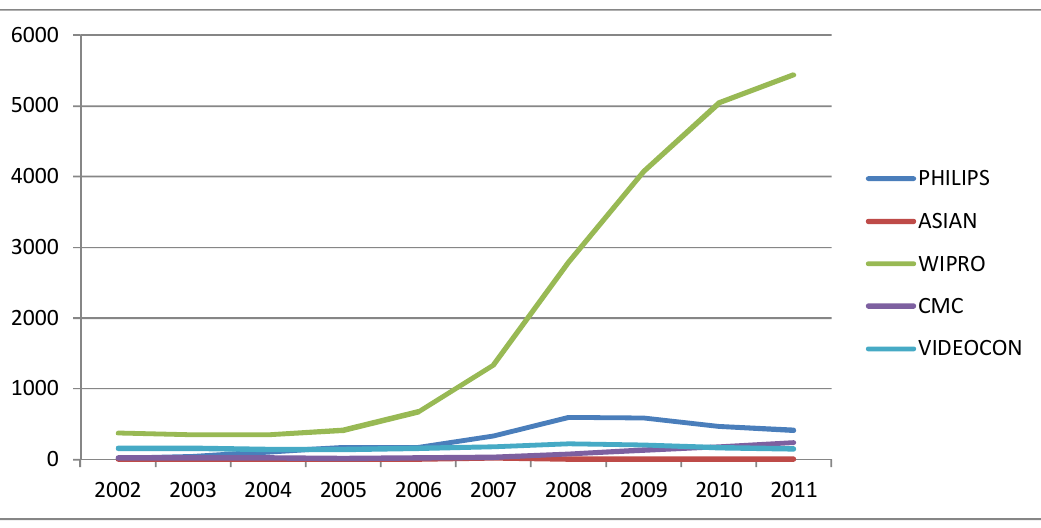
Fig. 1. Trend of cash